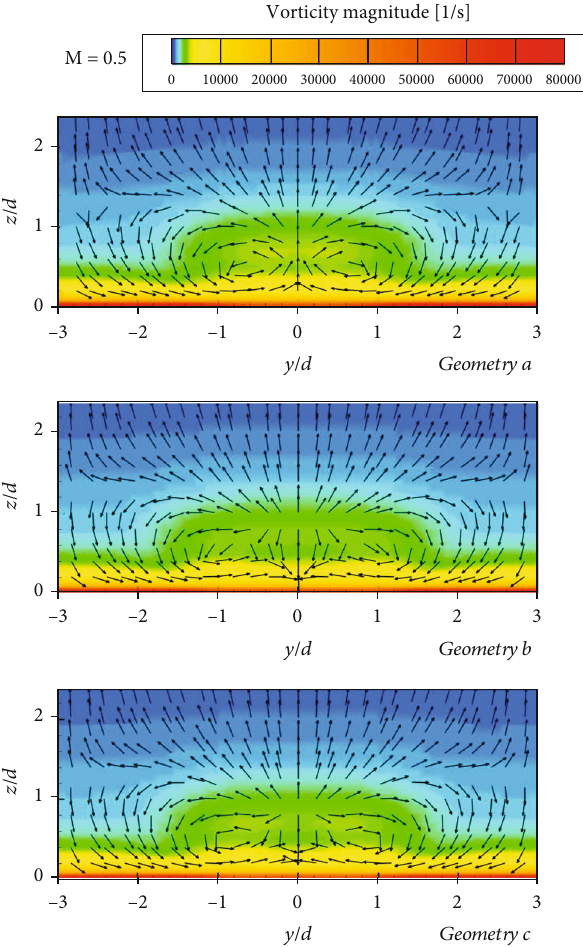
Figure 17: Vorticity magnitude contours and velocity vectors at x /d = 5 , for the three fi lm hole geometries, M = 1